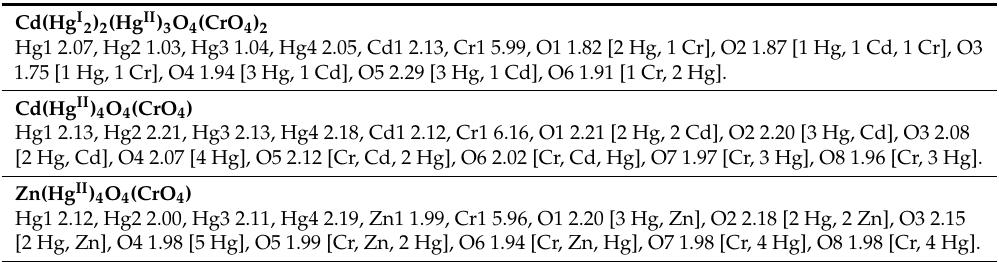
Table 2. Results of bond valence calculations/valence units (1) .